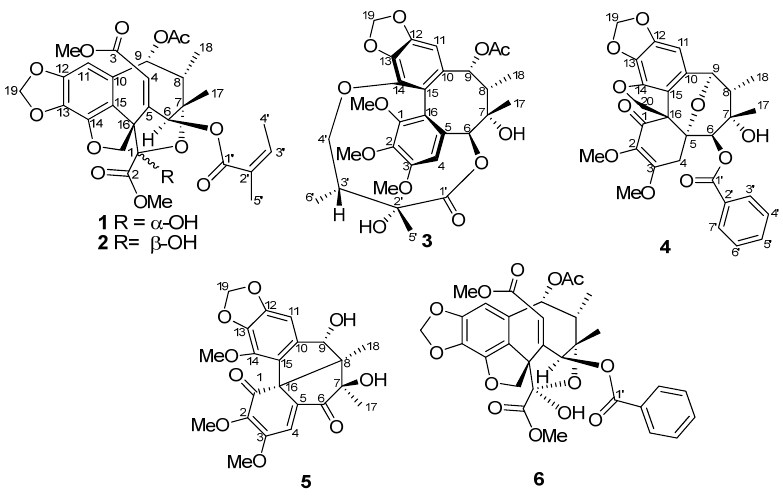
Figure 1. Chemical structures of compounds 1 – 6